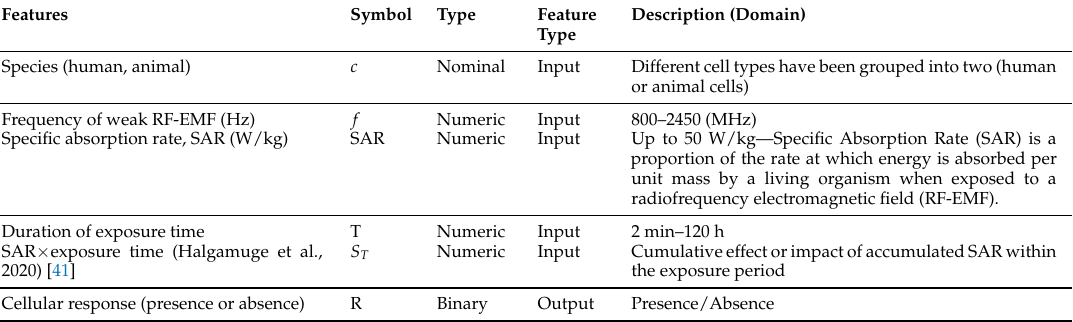
Table 2. Descriptions of the selected six features (attributes or variables) of the